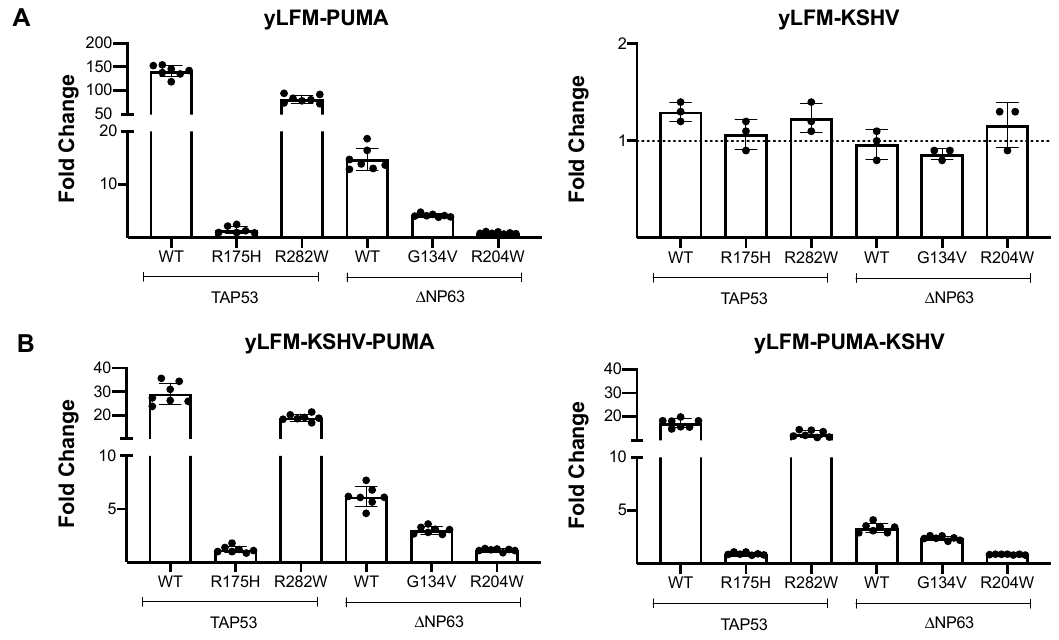
Figure 3. Fold change transactivation by mutant P53 family proteins. Yeast cells expressing wild-type and mutant TAP53 or ∆ NP63 proteins by an inducible GAL1,10 promoter were grown for 8 h in Galactose 1% to evaluate the transactivation ability. ( A ) Evaluation of wild-type (TAP53: full-length P53; ∆ NP63: ∆ NP63 α ) or mutant (TAP53: R175H and R282W; ∆ NP63: G134V and R204W) P53 and P63 proteins transcriptional activity as fold change over the empty vector in presence of the P53 RE from the PUMA target gene (yLFM-PUMA) or a G4 prone sequence (yLFM-KSHV). ( B ) Evaluation of transcriptional activity as in panel ( A ) in presence of the G4 prone sequence upstream (yLFM-KSHV-PUMA strain) or downstream (yLFM-PUMA-KSHV) of the P53 RE from the PUMA target gene. WT, wild-type.